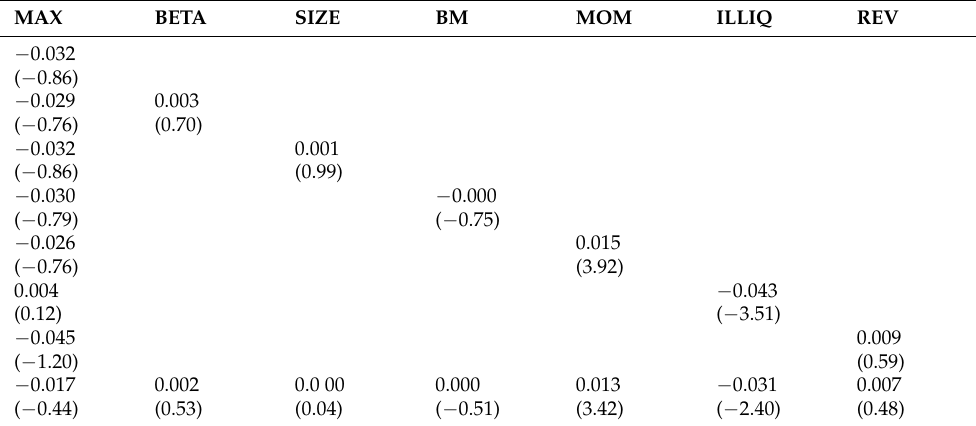
adjusted t-statistics in parenthesis, of firm-level cross-sectional FM regression results. The first panel reports univariate and bivariate regressions results, and the last row reports results of the full-specification multiple regression. The data are from January 1998 to December